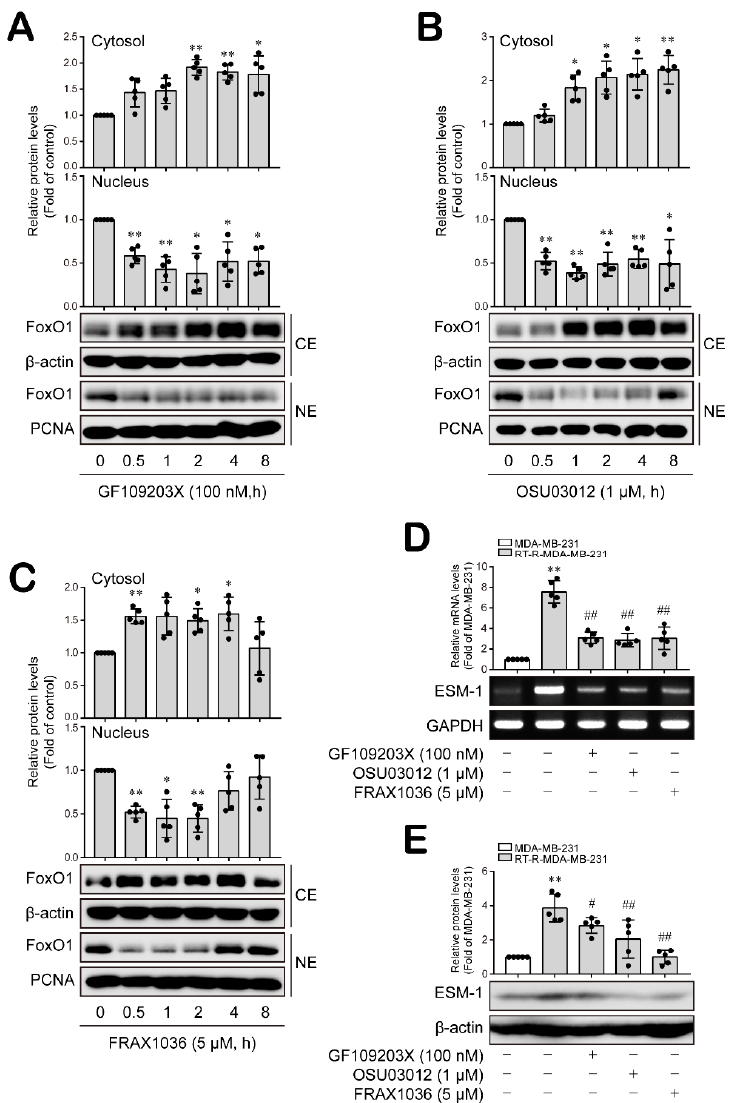
Figure 5. Nuclear FoxO1 levels and ESM-1 expression were regulated by PKC, PDK1 and PAK1 in RT-R-MDA-MB-231 cells. ( A – C ) RT-R-MDA-MB-231 cells were treated with GF109230X (100 nM), OSU03012 (1 µM) and FRAX1036 (5 µM) for the indicated times, and nuclear/cytosolic protein was extracted from the cells. FoxO1 protein expression levels in the cytosol or nucleus were analyzed by Western blotting. β -Actin and PCNA were used as loading controls. The values are presented as the mean ± SD of five independent experiments. * p < 0.05, ** p < 0.01 compared to the control. CE, cytosolic extract; NE, nuclear extract. ( D , E ) MDA-MB-231 and RT-R-MDA-MB-231 cells were treated with the indicated inhibitors for 8 h and 16 h before collection of total RNA and protein, respectively. ESM-1 and GAPDH mRNA levels were analyzed by RT–PCR. ESM-1 and β -actin protein levels were analyzed by Western blotting. The values are presented as the mean ± SD of five independent experiments. ** p < 0.01 compared to the MDA-MB-231 cells; # p < 0.05, ## p < 0.01 compared to the untreated RT-R-MDA-MB-231 cells.